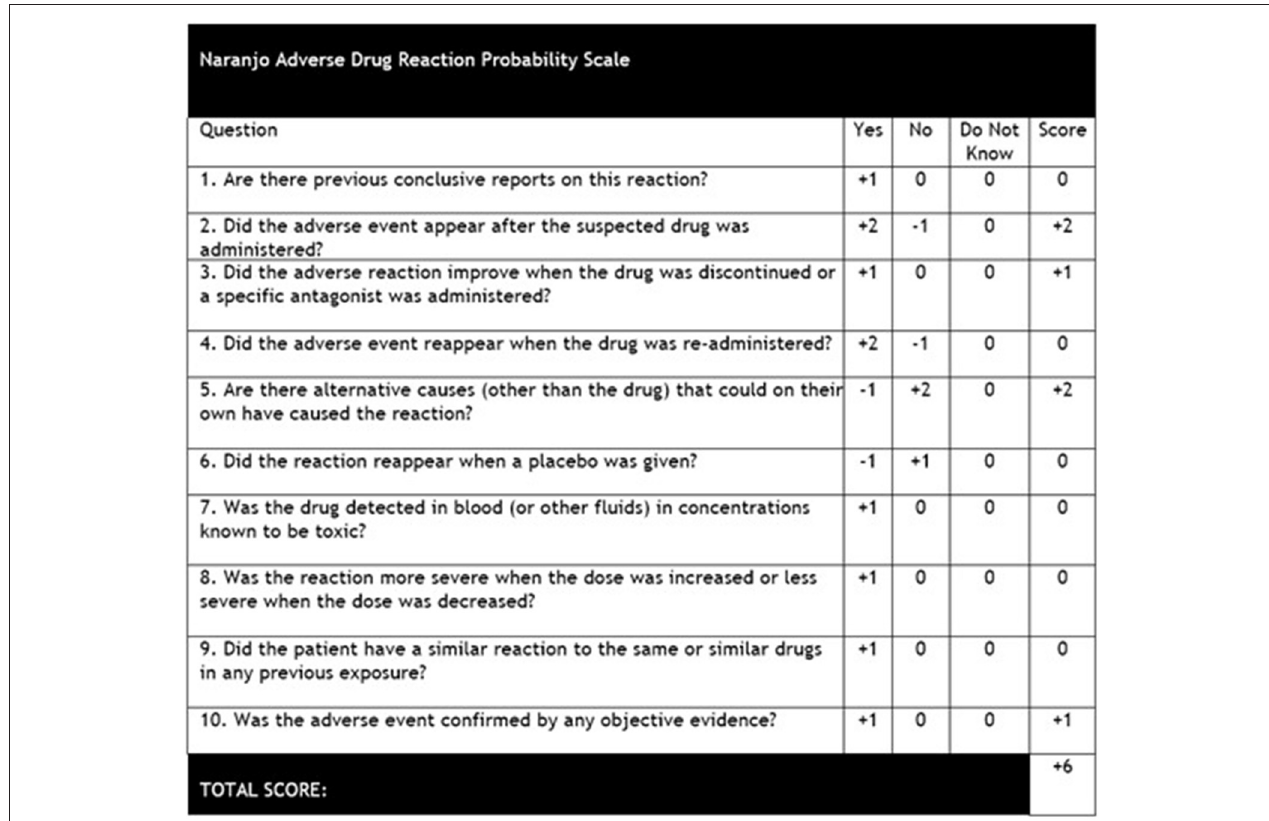
FIGURE 3 | Naranjo adverse drug reaction probability scale (9). Score was calculated as “ + 6” due to the patient’s adverse event appearing following administration of Clobazam, improvement of symptoms following discontinuation of the drug, other causes for the patient’s tongue edema ruled out, and the results of the patient’s presentation and work-up confirmed with neurology, immunology, and otolaryngology consults.